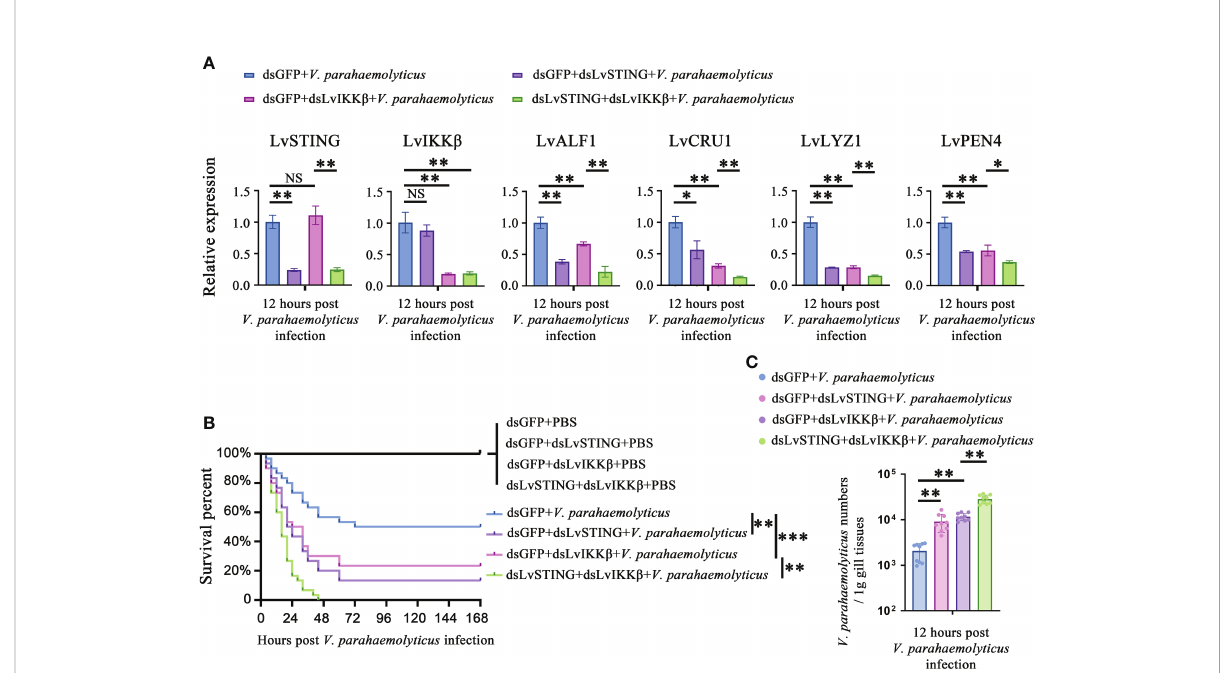
FIGURE 6 The LvSTING – LvIKK b – LvRelish – AMPs axis played a protective role against V. parahaemolyticus. ( A ) Relative expression of LvSTING, LvIKK b and AMPs in the hemocytes from dsLvIKK b or dsGFP treated shrimp with or without dsLvSTING injection at 12 hours post V. parahaemolyticus infection. (B) Percent survival of dsLvIKK b or dsGFP treated shrimp with or without dsLvSTING injection after V. parahaemolyticus infection. The experiments were performed three times with identical results. Differences between groups were analyzed with Log-rank test using the software of GraphPad Prism 5.0 (** p < 0.01, *** p < 0.001). (C) V. parahaemolyticus numbers in gill tissues of dsLvIKK b or dsGFP treated shrimp with or without dsLvSTING injection at 12 hours post V. parahaemolyticus infection. One dot represents one sample and the column represents the median of the results. The data (A, C) was analyzed statistically by student ’ s T test (* p < 0.05, ** p < 0.01). ns, no signi fi cant